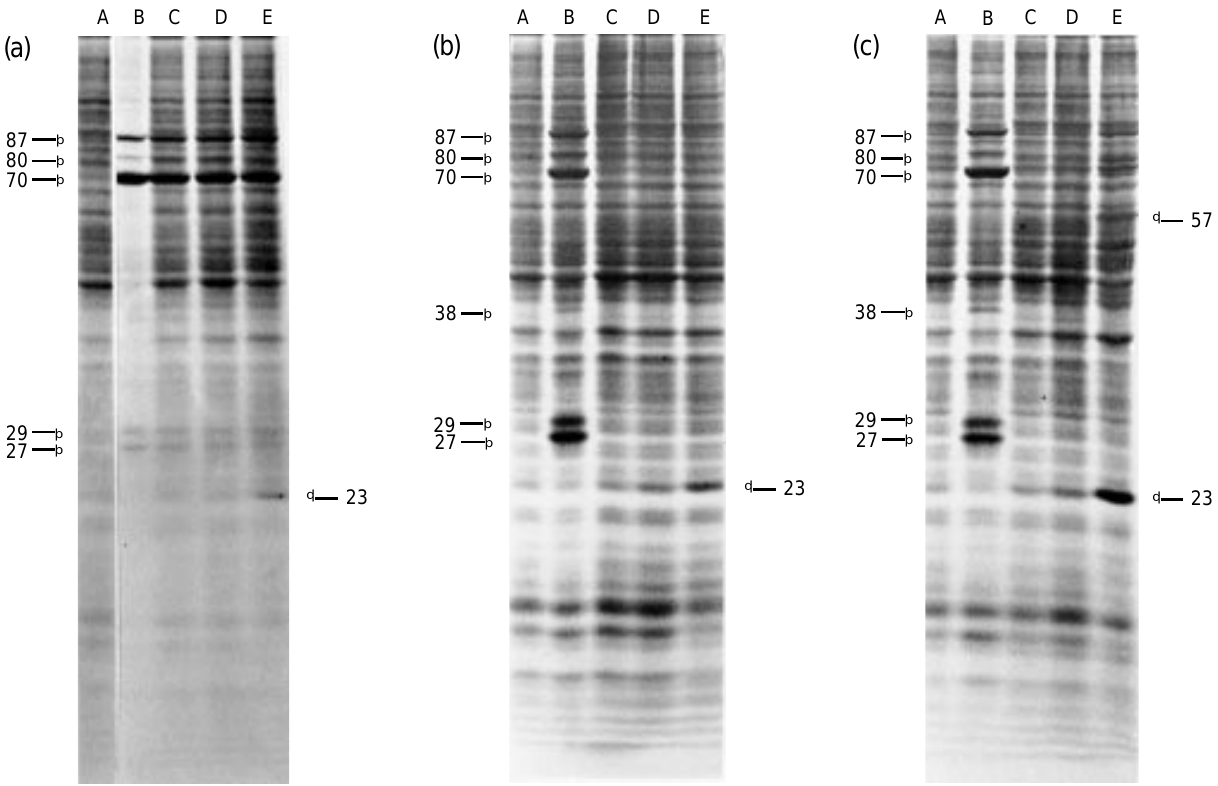
Figure 1 - Effect of PGA 1 on protein synthesis in growing A. albopictus cells in the lag phase (a), exponential phase (b), and stationary phase (c). Cell monolayers were labeled with 35 S-methionine and the proteins subjected to SDS-PAGE as described. Lane A represents untreated control cells maintained at 28 o C, lane B, heat-shocked cells, and lanes C, D and E, cells treated with PGA 1 at the concentrations of 0.25, 1.25 and 12.5 µg/ml,